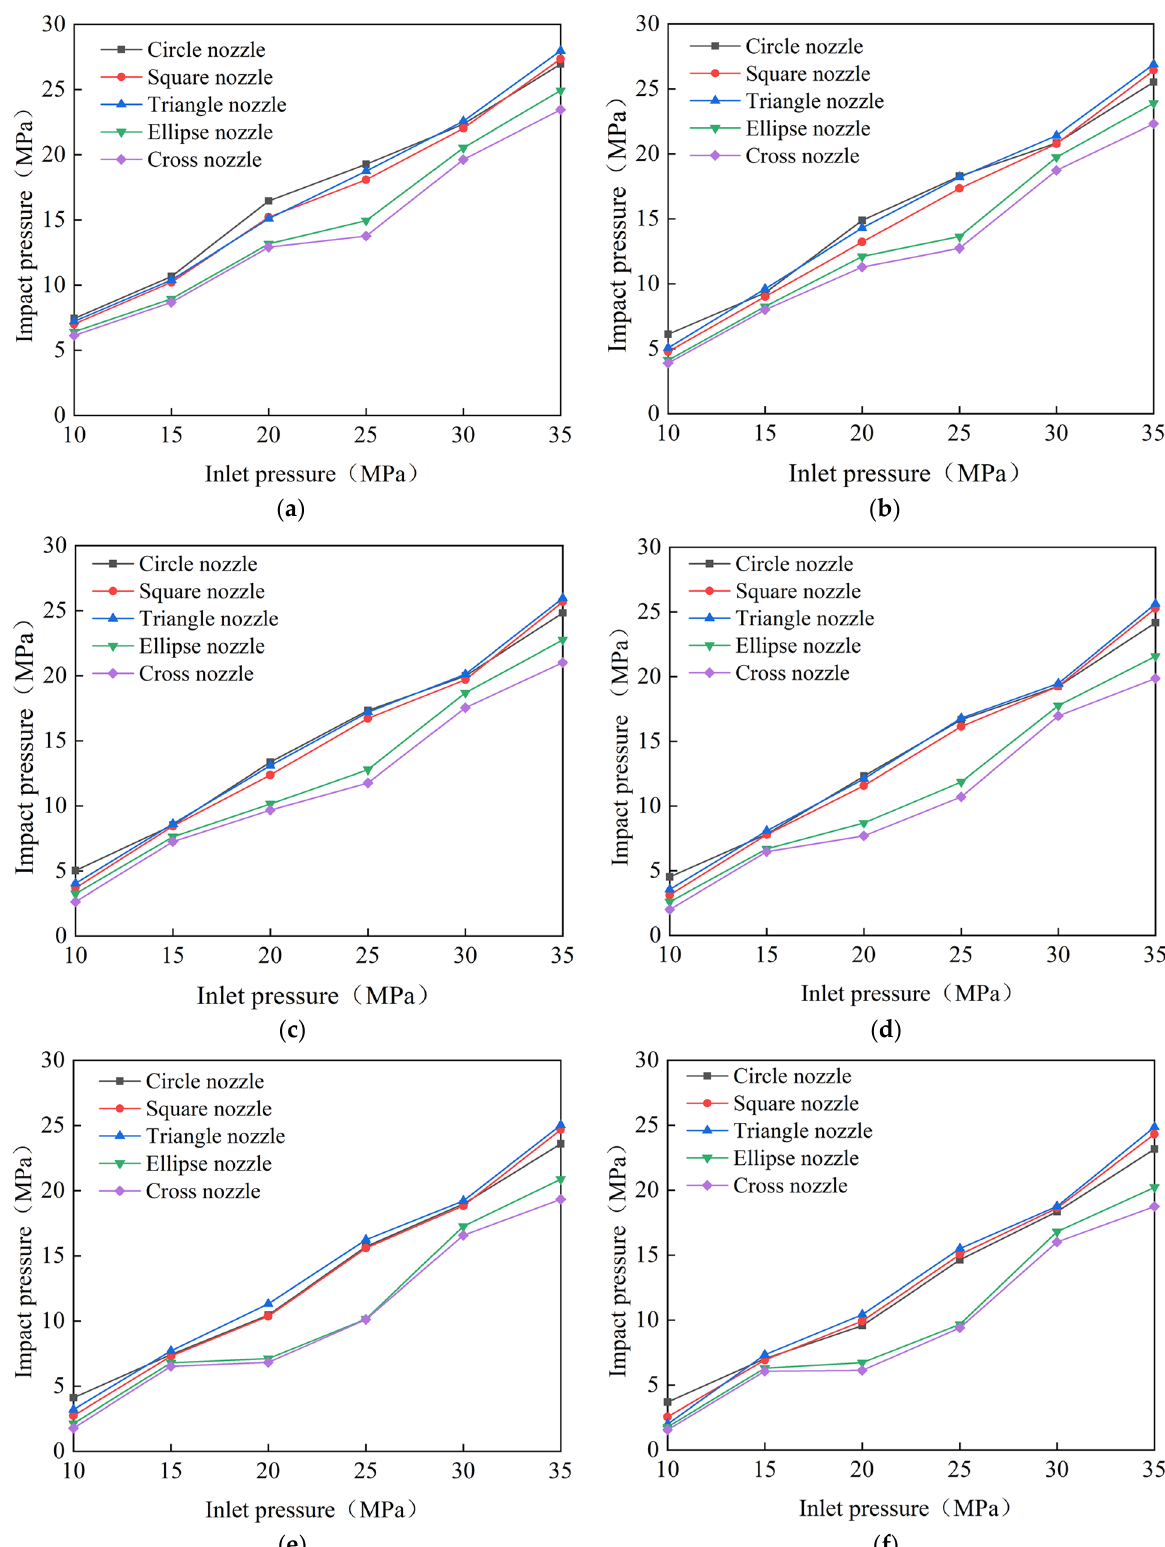
Figure 7. Effect of inlet pressure on the impact of the water jet pressure fordifferent nozzle shapes: ( a ) axial target distance X = 80 mm; ( b ) axial target distance X = 100 mm; ( c ) axial target distance X = 120 mm; ( d ) axial target distance X = 140 mm; ( e ) axial target distance X = 160 mm; ( f ) axial target distance X = 180 mm.